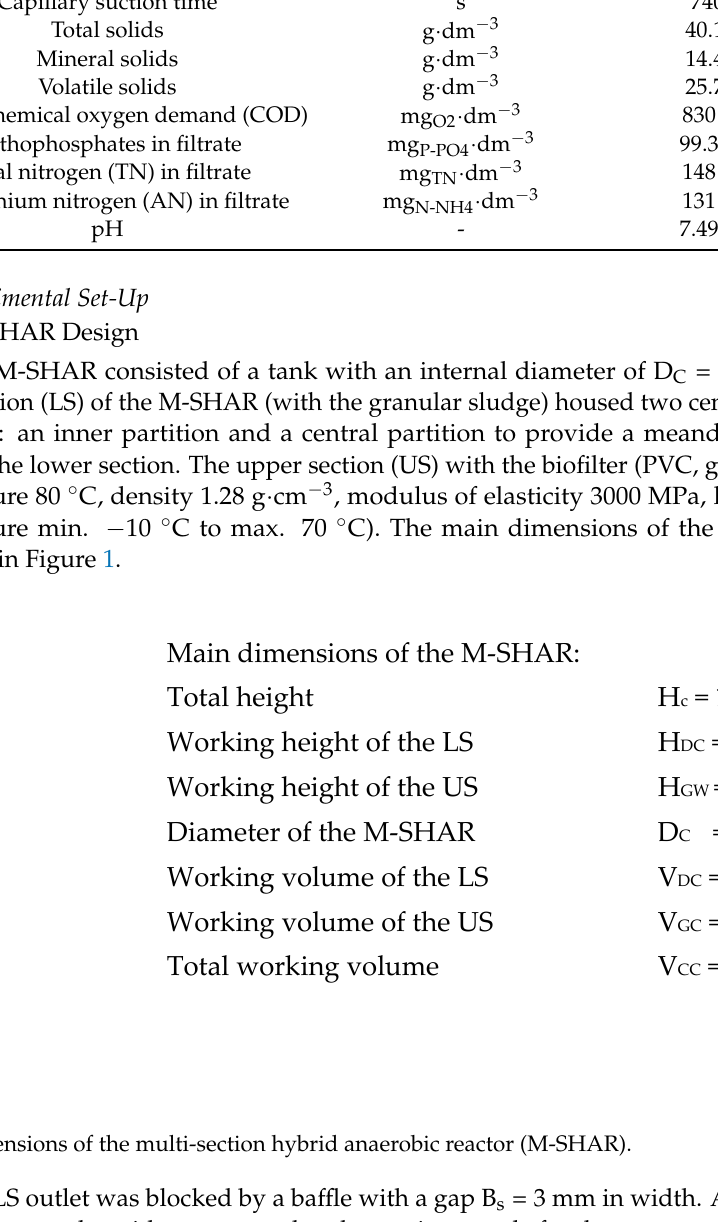
Table 3. Characteristics of the anaerobic inoculum used in the study.